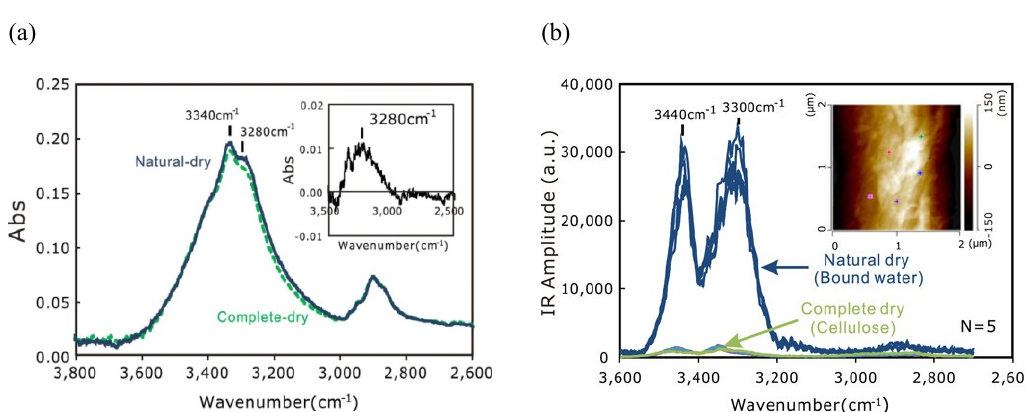
Figure 3. ( a ) Conventional ATR-IR spectra of dried cotton cellulose; ( b ) Direct observation of the interaction between water and cellulose by AFM-IR. Reproduced with permission from [49]. Copyright American Chemical Society, 2020.